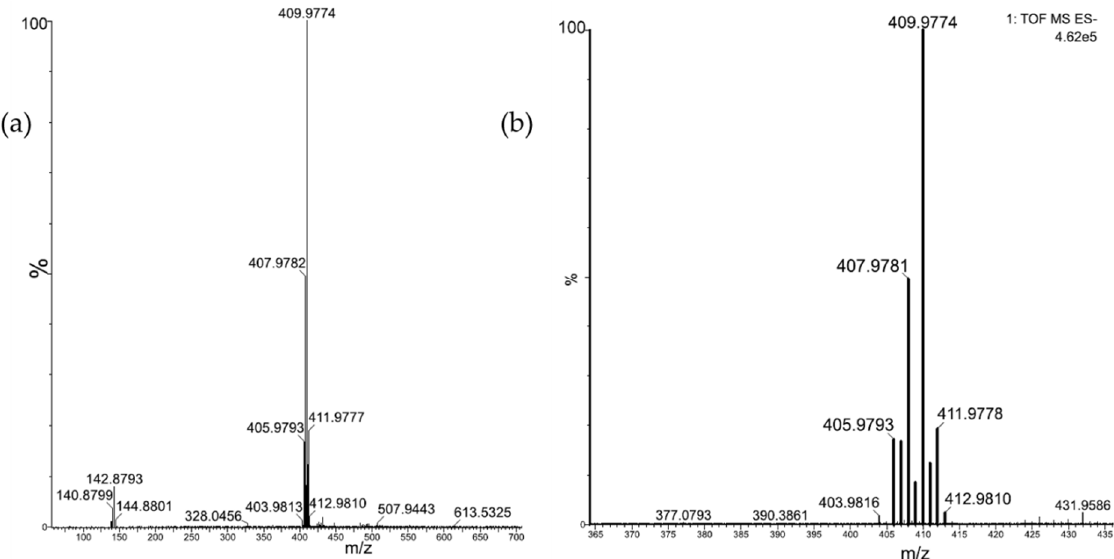
Figure 1. Negative MS-ESI spectrum of dGMPSe ( 4 ), calculated m/z 409.9778 amu, ( a ) and extension of the selenium iso- topic region, ( b ) the spectrum shows the typical isotopic distribution for the selenium derivative.